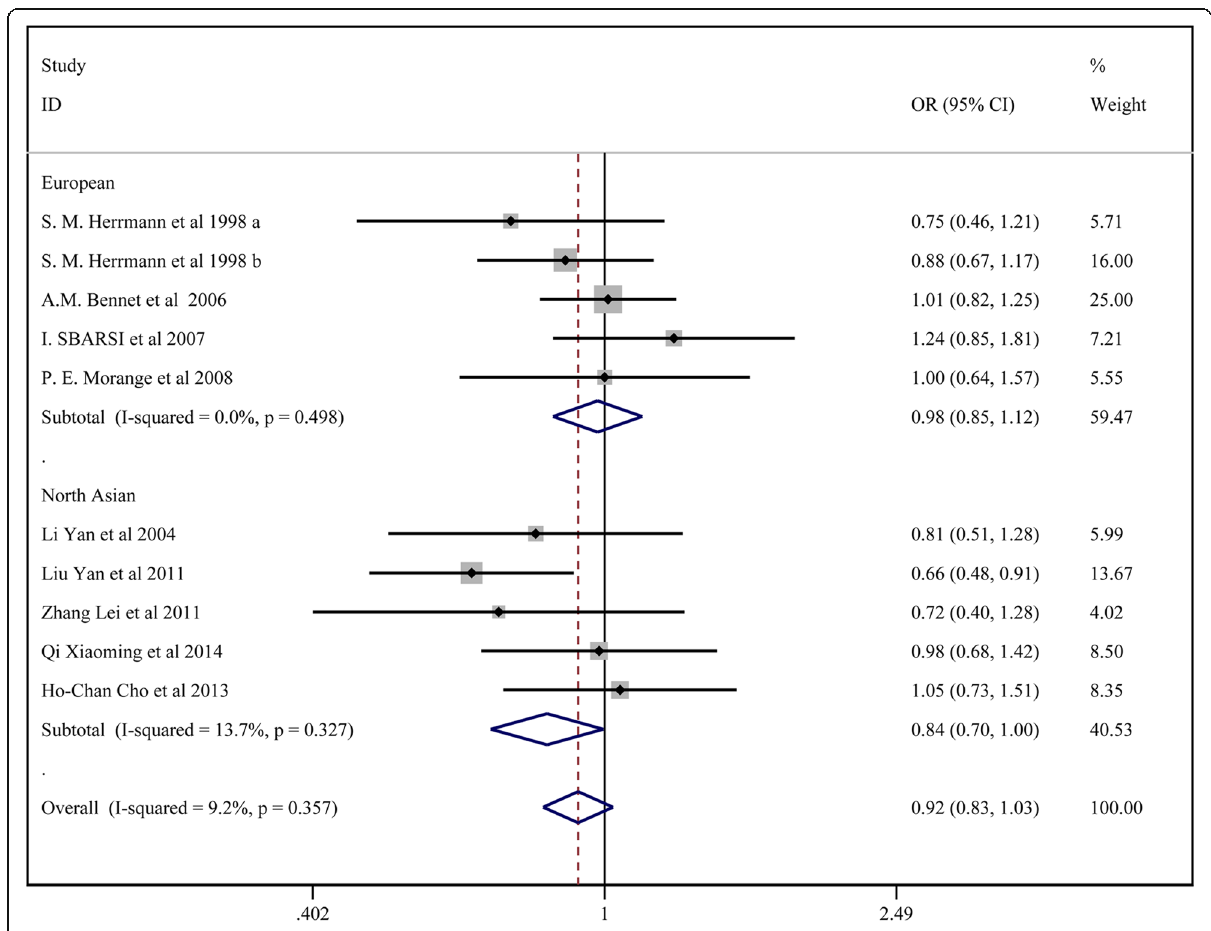
Fig. 6 Forest plot for the dominant model of TNF- α 857C/T polymorphisms associated with